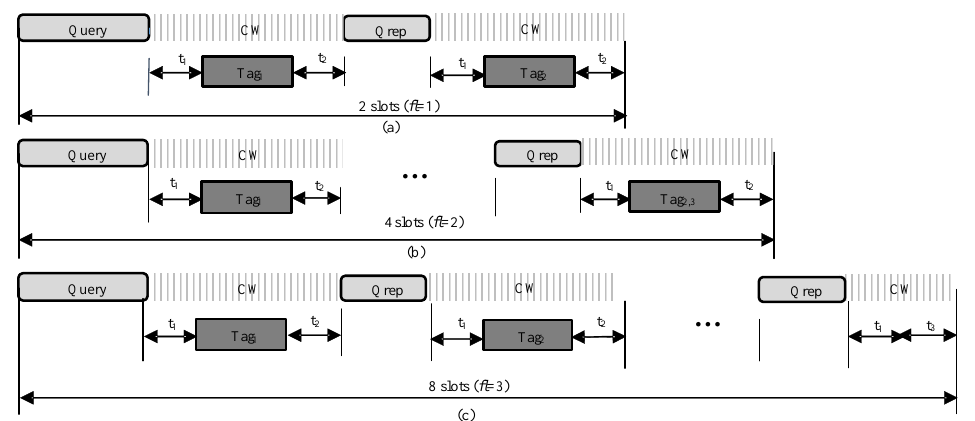
Figure 2. Frame slot structure: ( a ) when fl = 1, the frame consists of two slots; ( b ) when fl = 2, the frame consists of four slots; ( c ) when fl = 3, the frame consists of eight slots.